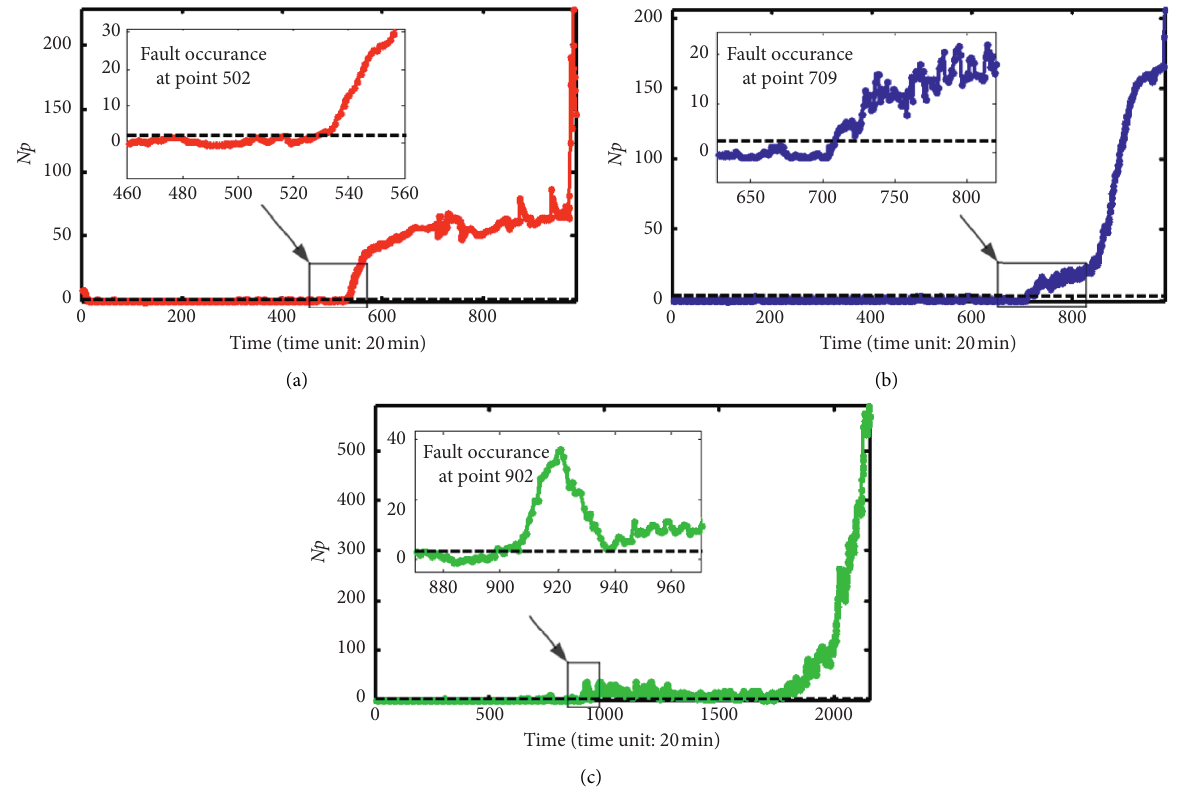
Figure 9: The assessment results and its local enlargement based on the proposed SGM-based FCC profile for the full cycle life of the three tested bearings: (a) bearing 2 of testing 2, (b) bearing 4 of testing 2, and (c) bearing 3 of testing 1 (the black dotted line is the corresponding threshold calculated by the KDE